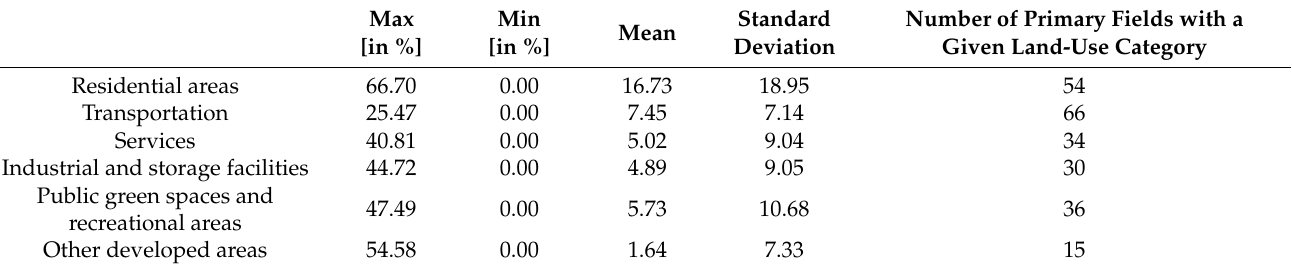
Table 2. Basic statistical data from an analysis of primary